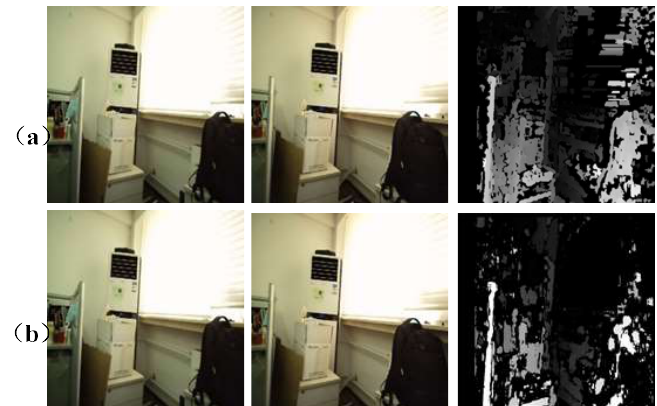
Figure 9. Comparison of disparity maps obtained by two algorithms: ( a ) SGBM algorithm; ( b ) BM algorithm.